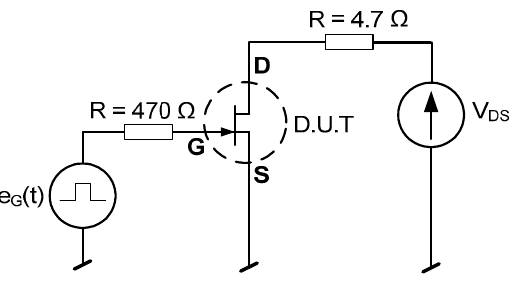
Figure 9. Switching circuit of the transistor.